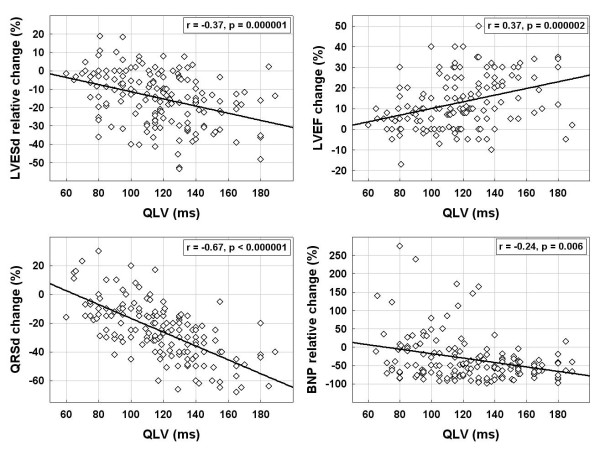
Relationship of the QLV and CRT effects. The greater QLV at implantation of CRT system correlates with an increase in LVEF, decrease in LVESD, shortening of QRSd, and reduction in NT-proBNP at 12-month follow-up. Pearsons’s correlation coefficients (r) with p-values are provided. Abbreviations as in Table 1.